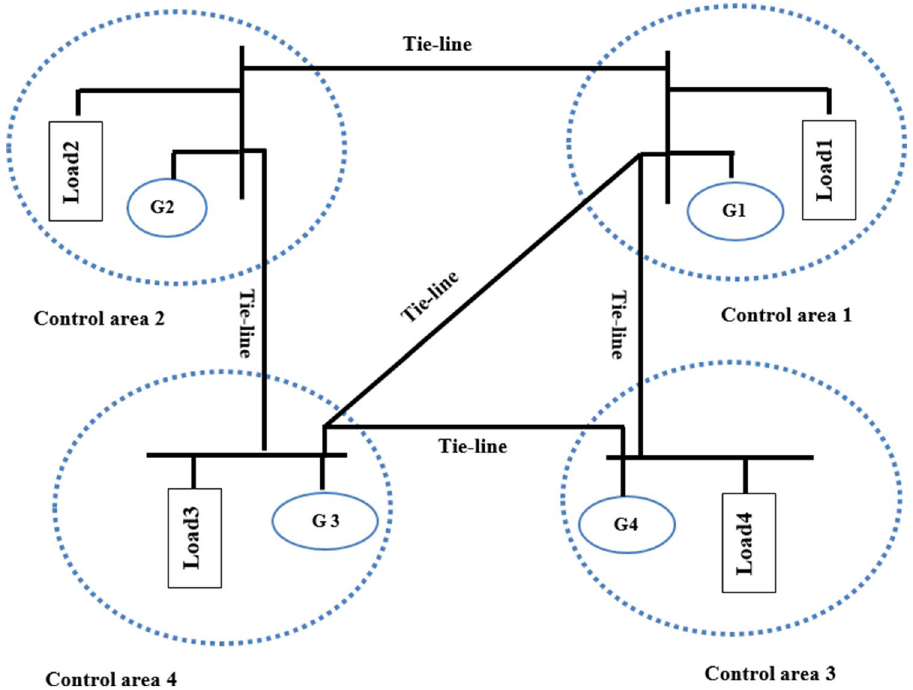
Figure 3. Proposed four area interconnected power system with tie-lines